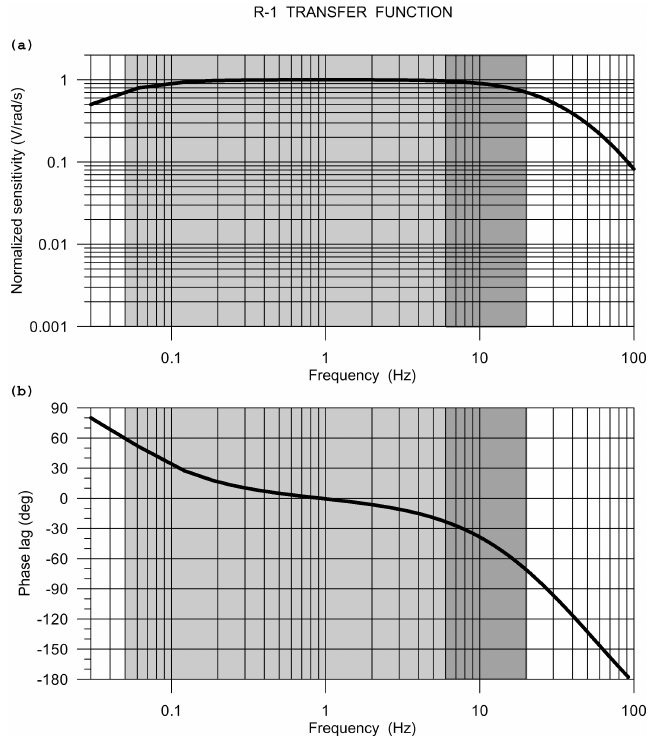
Figure 3. The Eentec R-1 frequency response: modulus ( a ) and phase ( b ). The response is calculated from poles and zeros specified by the manufacturer. Grey intervals indicate the specified frequency range, the dark grey rectangles mark the range actually considered in the comparative